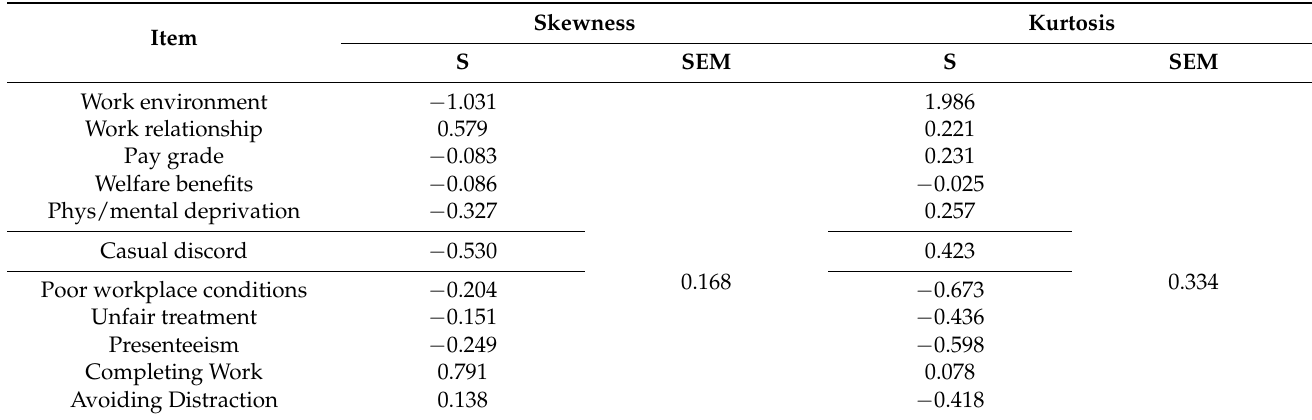
Table 4. Confirmatory factor analysis of each potential variable and reliability results.